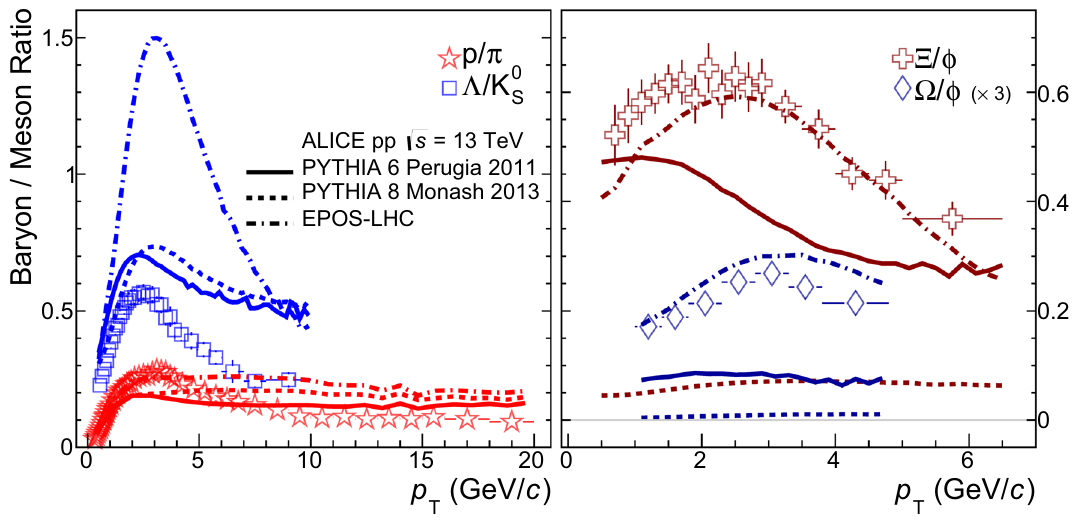
√ s = 13 TeV. The data are compared